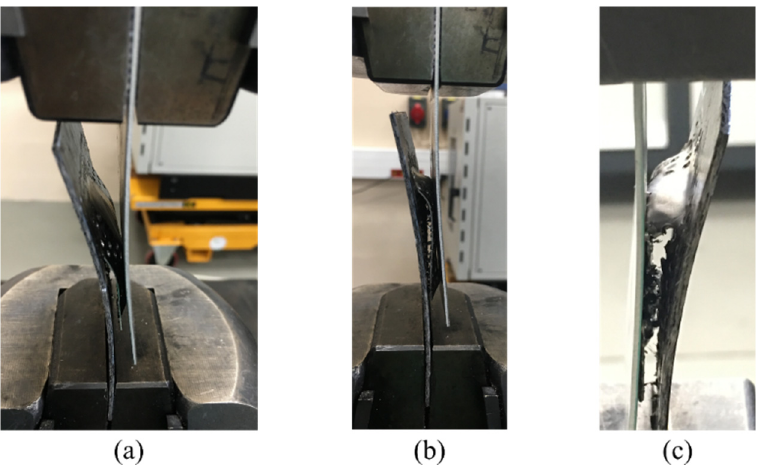
Metals 2021 , 11 , x FOR PEER REVIEW Figure 10. Stills from the failure of the perforated aluminum 5754 insert during lap-shear tests. The corresponding fractured surfaces are shown respectively in Figure 11a–c.